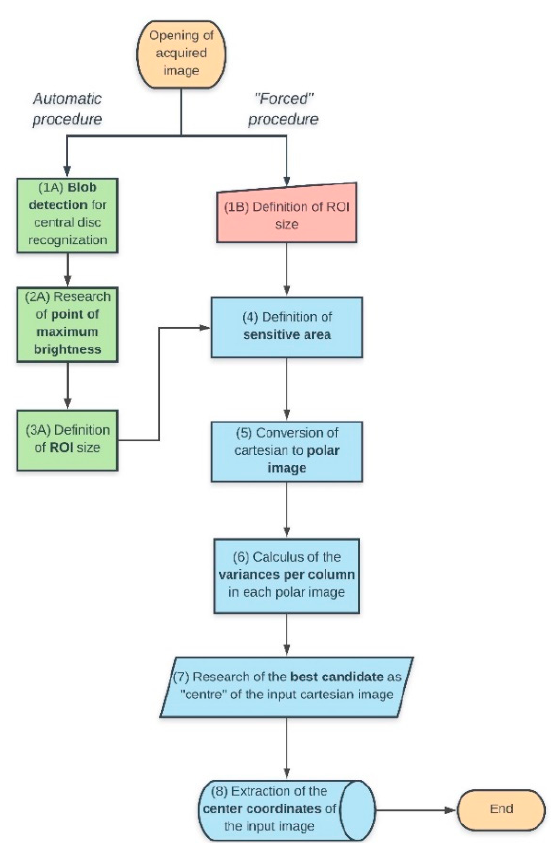
Figure 10. Block diagram of the variance-based approach to the problem.